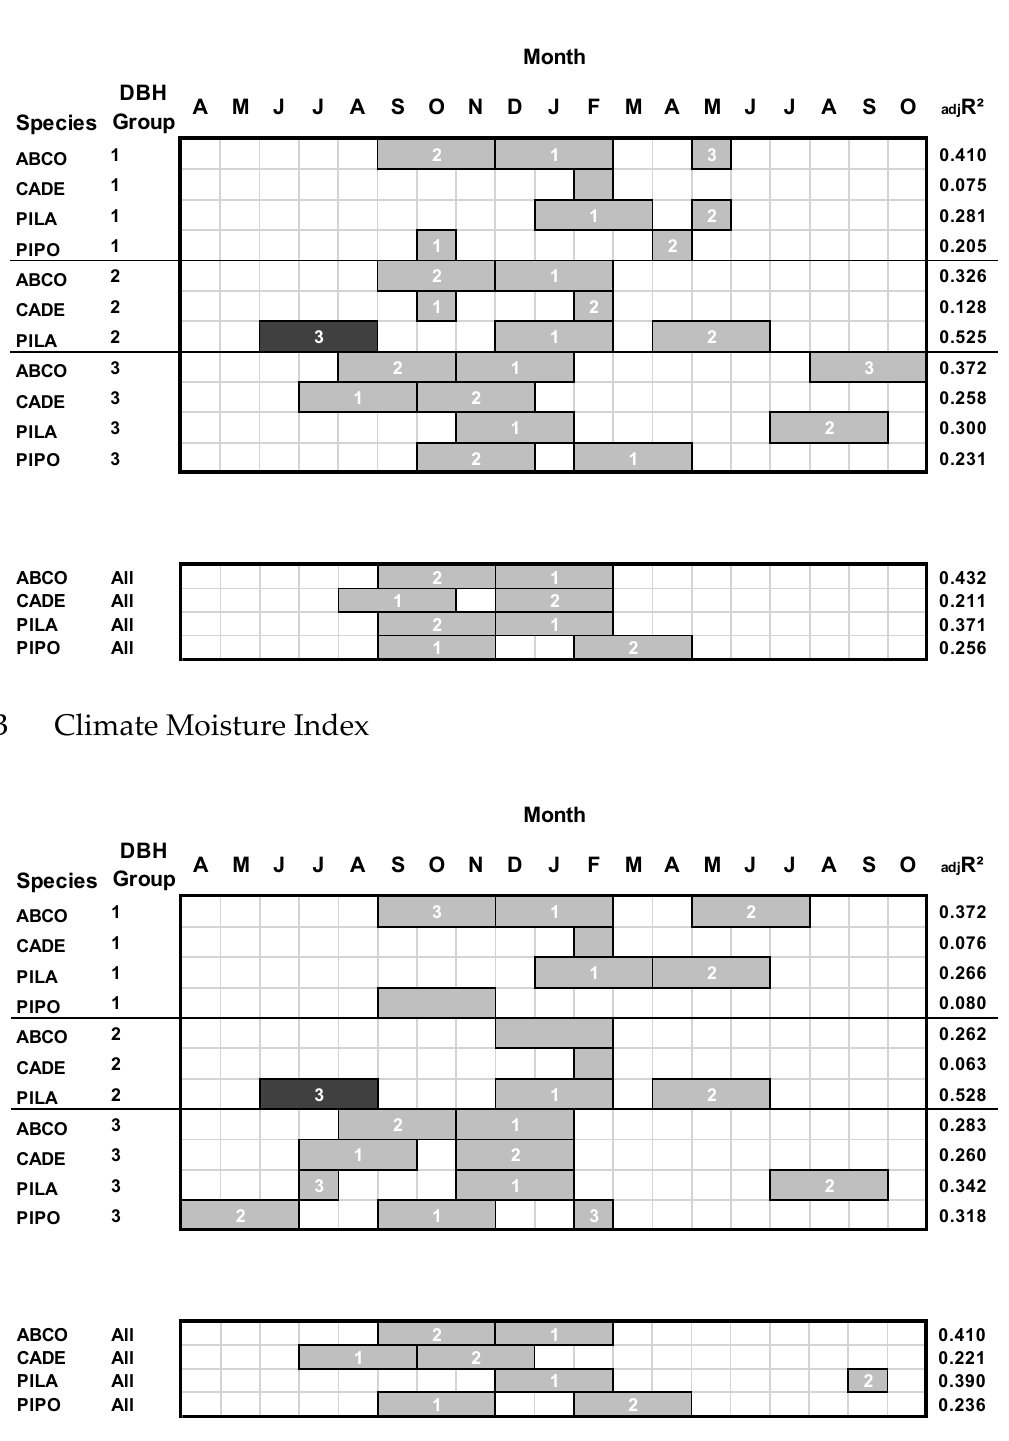
Figure 6. Statistically significant ( p < 0.05) growth responses to ( A , B ) by species and diameter size group and for each species as a whole (i.e., with all diameter groups combined). Darker coloring indicates a negative correlation with growth, whereas lighter coloring indicates a positive correlation with growth. Numbers indicate the order of importance for that relationship, with 1 being the most important (according to the standardized partial regression coefficients). Explanatory climate variables expressed either for a monthly period or a 3-month seasonal period.